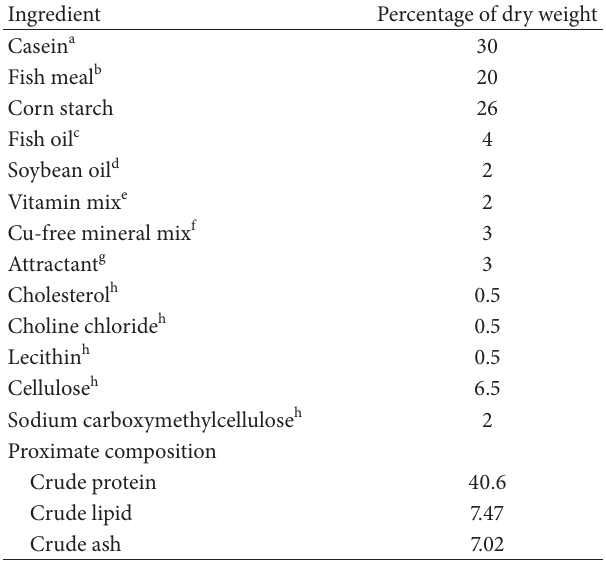
Table 1: Ingredients and compositions of experimental diets